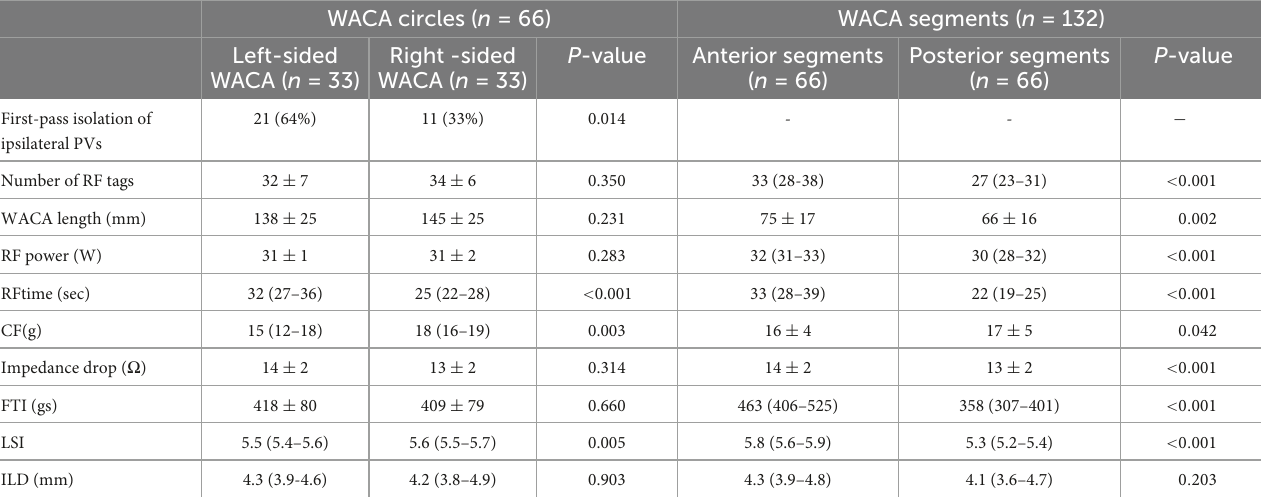
TABLE 2 Ablation data from the index procedure. WACA circles ( n = 66) WACA segments ( n = 132) Left-sided Right -sided P -value Anterior segments Posterior segments P WACA ( n = 33) WACA ( n = 33) ( n = 66) ( n = 66)